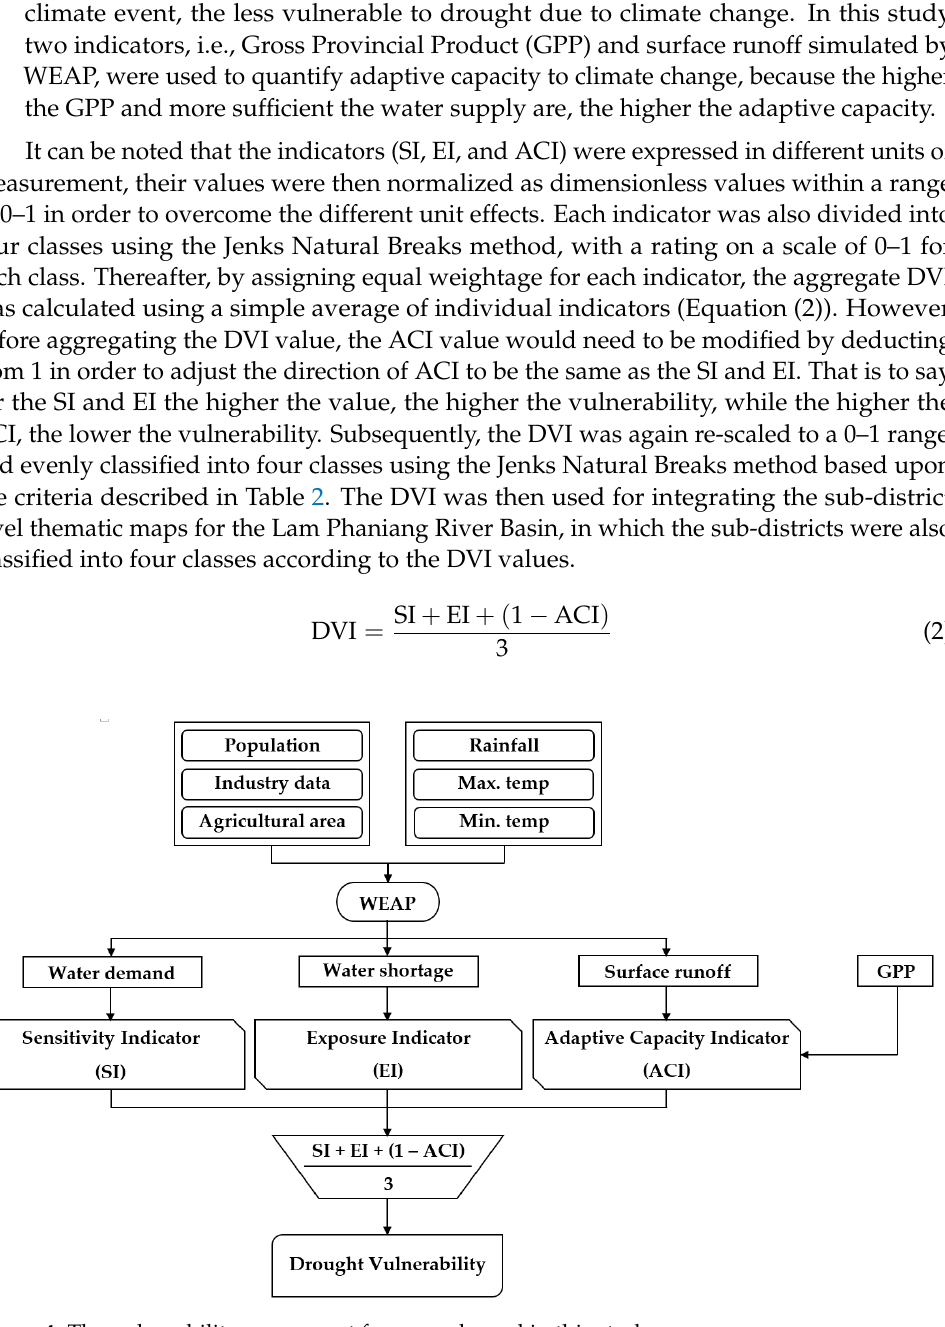
Figure 4. The vulnerability assessment framework used in this study